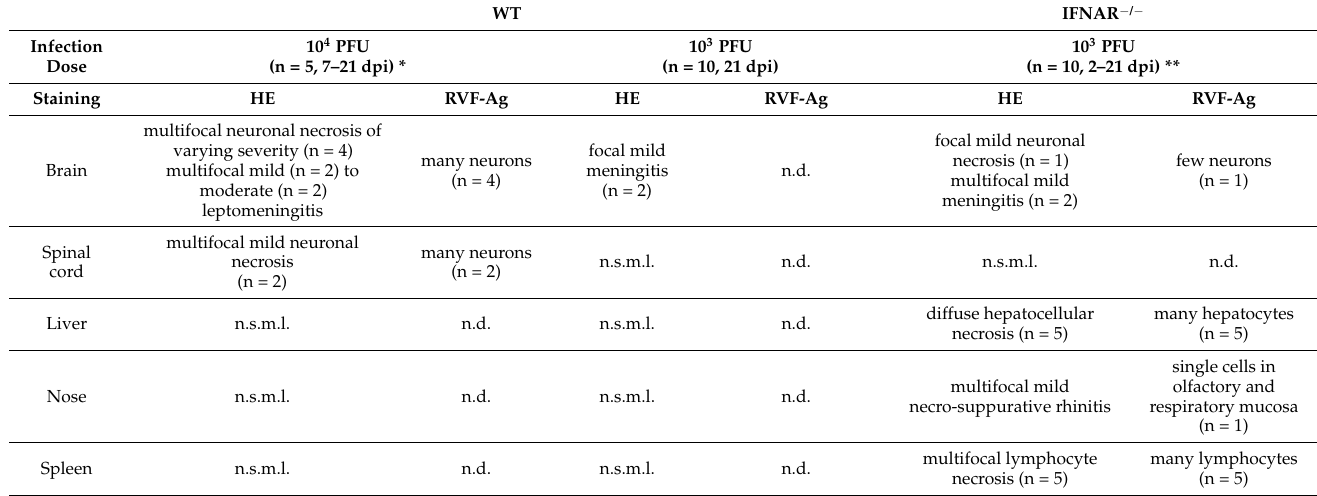
Table 1. Histological findings and immunohistochemical detection of RVFV nucleoprotein. WT IFNAR − / − Infection